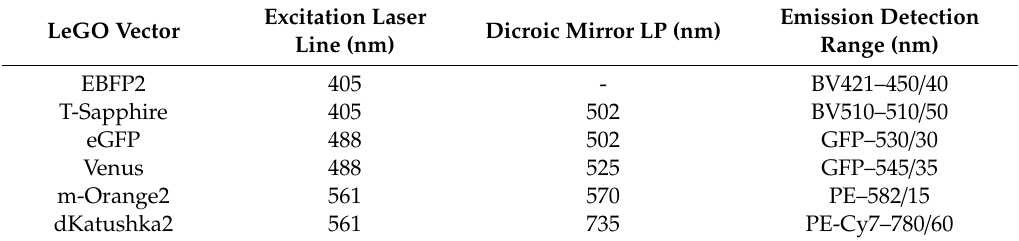
Table 2. FACS laser excitation and emission set up.